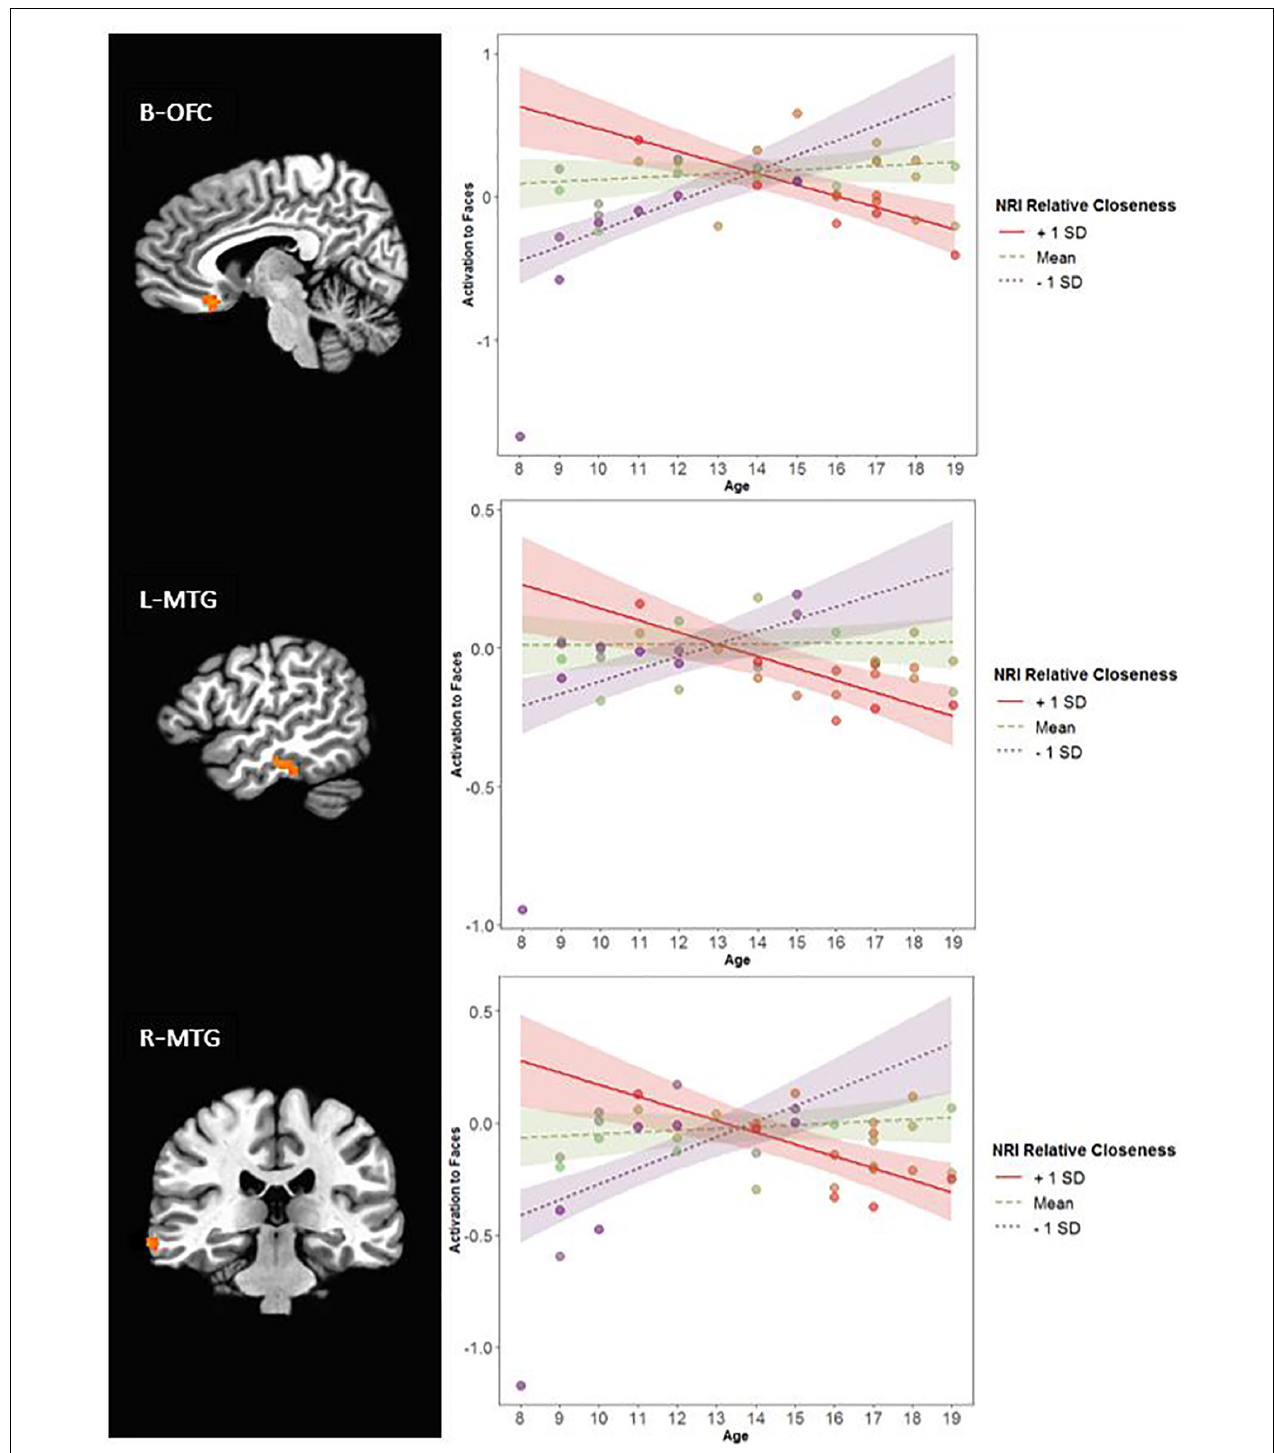
FIGURE 6 | Interaction between participants’ relative closeness and age on neural activation during stimulus presentation. R, right; L, left; B, bilateral. OFC, orbitofrontal cortex; MTG, middle temporal gyrus. Clusters were formed using 3dclustsim at p < 0.001, with a cluster size threshold of 27 voxels. Brain images are rendered in the Talairach-Tournoux template space. Refer to Table 2 for description of regions of activation. Plotted activation in the line graphs represents estimated activation at low levels of Relative Closeness (–1 standard deviation), mean levels of Relative Closeness, and high levels of Relative Closeness ( + 1 standard deviation). SD, standard deviation. Colored bands surrounding the regression lines represent 95% confidence intervals. Of note, all interactions remained significant when the 8-year-old participant with low activation in these regions was removed.